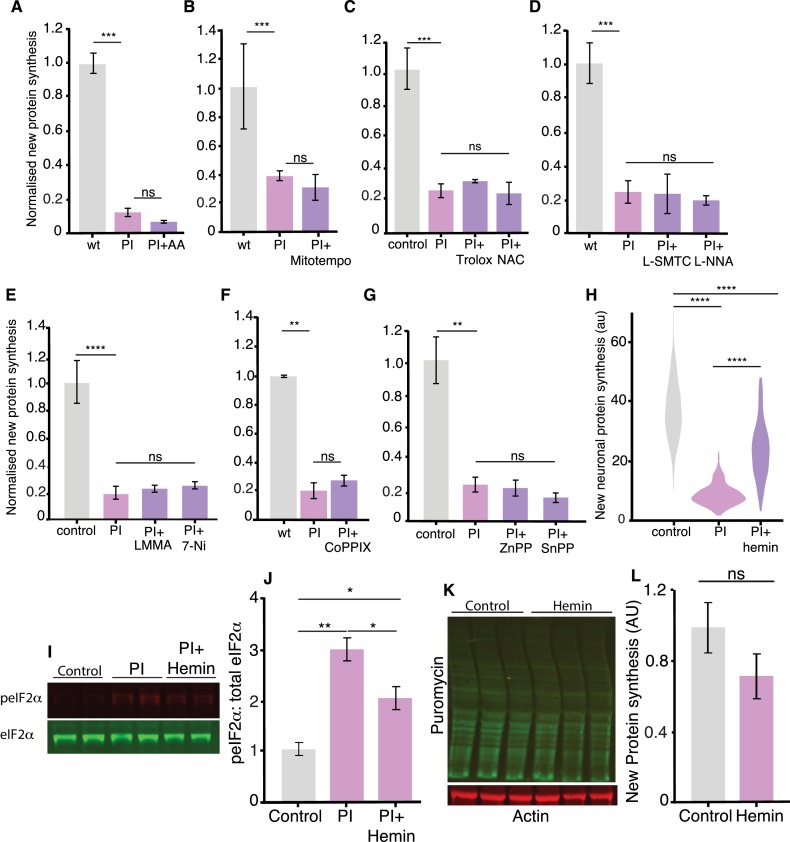
Experiments addressing the mechanism of HRI activation.Analysis of experiments examining the effect of quenching reactive oxygen species (ROS) (A–C), blocking nitric oxide synthase (D, E) or heme oxygenase (F, G) activity on the PI-induced decrease in protein synthesis (measured using puromycylation- see Materials and methods). None of these treatments resulted in a significant alteration of the PI-induced decrease in protein synthesis: in A; PI vs. control, p≤0.001; PI vs. PI + AA p>0.05; in B PI vs. control, p≤0.001, PI vs. PI+ Mitotempo p≥0.05; in C, PI vs. control, p≤0.001 PI vs. PI+ Trolox and PI+ NAC p≥0.05; in D PI vs. control, p≤0.001, PI vs. PI +SMTC and PI +LNNA p≥0.05; in E PI vs. control, p≤0.0001 PI vs. PI+ LMMA and PI+ 7-Ni p≥0.05; in F, PI vs. control, p≤0.01; PI vs. PI +CoPPIX p≥0.05; in G PI vs. control, p≤0.01 PI +ZnPPIX and PI vs. PI+ SnPPIX p≥0.05 Unpaired t-test for all analyses (n = 2 experiments per condition). Error bars = SD. (H) Analysis of experiments examining neuronal protein synthesis in situ using puromycylation showing that hemin significantly rescues the inhibition of protein synthesis in neurons PI (n = 244) vs. control (n = 243), p≤0.0001; PI vs. PI +hemin (n = 285) p≤0.0001, Unpaired t-test for all analyses (n = 2 experiments, two dishes were imaged per experiment per condition). (I) Western blot showing the of the phosphorylation levels of eIF2α after proteasome inhibition in the presence of hemin. (J) Quantification of the experiments shown in I. (K) Western blot of protein synthesis in the presence of hemin, actin is shown as loading control. (L) Quantification of the experiments shown in K normalized with actin, normalized to the control condition.Figure 5—figure supplement 2—source data 1.Source data for Figure 5—figure supplement 2A, B, C, D, E, F, G, H, L.Figure 5—figure supplement 2—source data 2.Source data for Figure 5—figure supplement 2I,K.